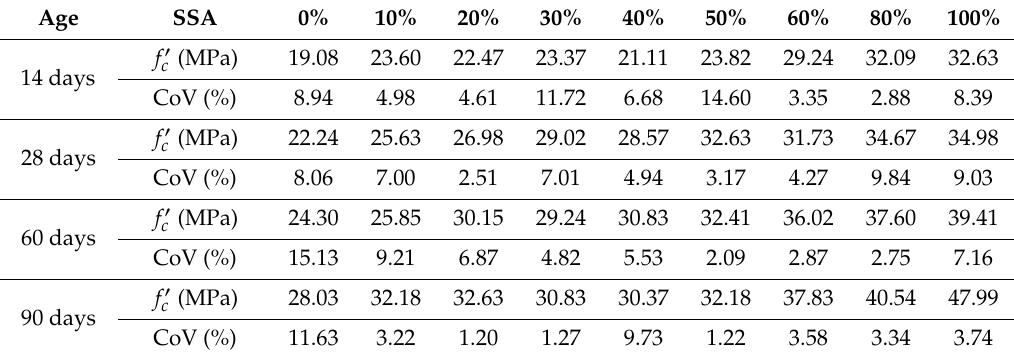
Table 7. The average compressive strength ( f (cid:48) c ) and coe ffi cient of variation (CoV) of